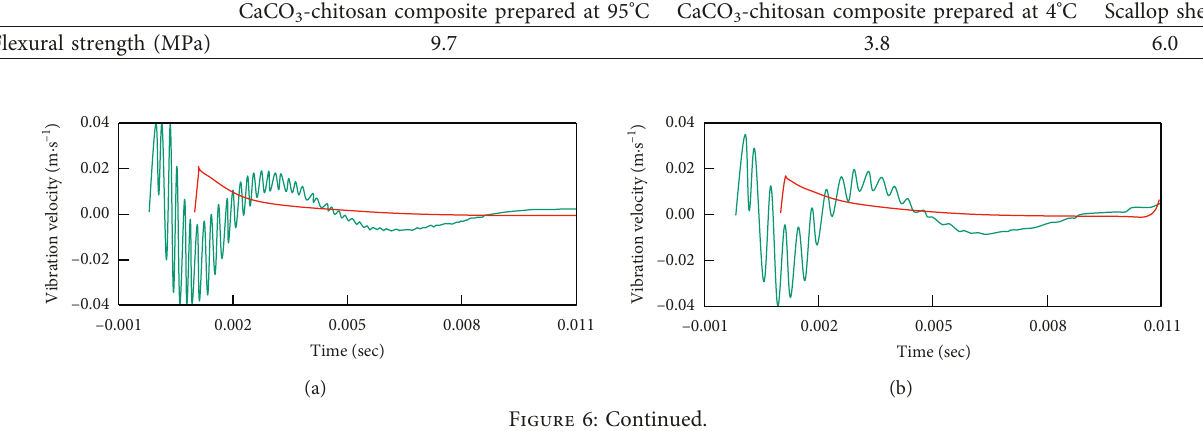
Figure 5: Scanning electron microscopy images obtained before and after hydrothermal hot pressing: (a) CaCO 3 -chitosan composite prepared at 95 ° C before HHP and (b) molded solid obtained by HHP; (c) CaCO 3 -chitosan composite prepared at 4 ° C before HHP and (d) molded solid obtained by HHP; and (e) milled scallop shells before HHP and (f) molded solid obtained by HHP. Table 1: Flexural strength of molded composites obtained by the HHP